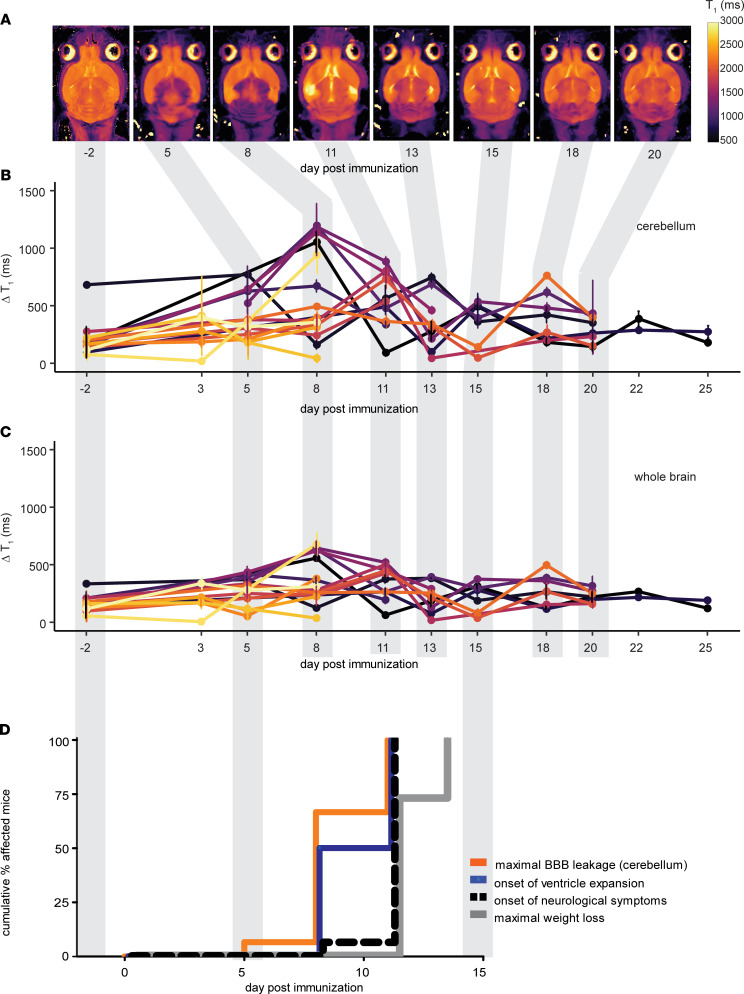
Ventricle enlargement coincides with gadolinium-enhancing lesions and precedes EAE clinical signs.(A) T1 map MRIs of a representative mouse brain show altered tissue relaxation due to blood-brain barrier disruption following administration of gadolinium-based contrast agent. Reduced tissue T1 (purple) is apparent in the meninges, cerebellum, and periventricular regions already by day 5 p.i. Note that the brain images have been registered to the baseline image for quantification; therefore, changes in ventricle volume are not apparent in these images. (B) Quantification of global changes in tissue T1 following gadolinium contrast administration were especially prominent in the cerebellum (n = 16). The ΔT1 (precontrast – postcontrast values) was significantly increased from baseline at days 8–11 p.i. (P = 0.0030, ANOVA). (C) The ΔT1 of the whole-brain was also significantly increased at days 8–11 p.i. (P = 0.0023, ANOVA). (D) Kaplan-Meier plots show that the time of onset of ventricle expansion and the time of maximal gadolinium enhancement significantly preceded the onset of EAE clinical signs (P = 0.0068 and P = 0.0005, respectively; log-rank test) and the time of maximal body weight loss (P = 0.008, P < 0.0001, respectively).